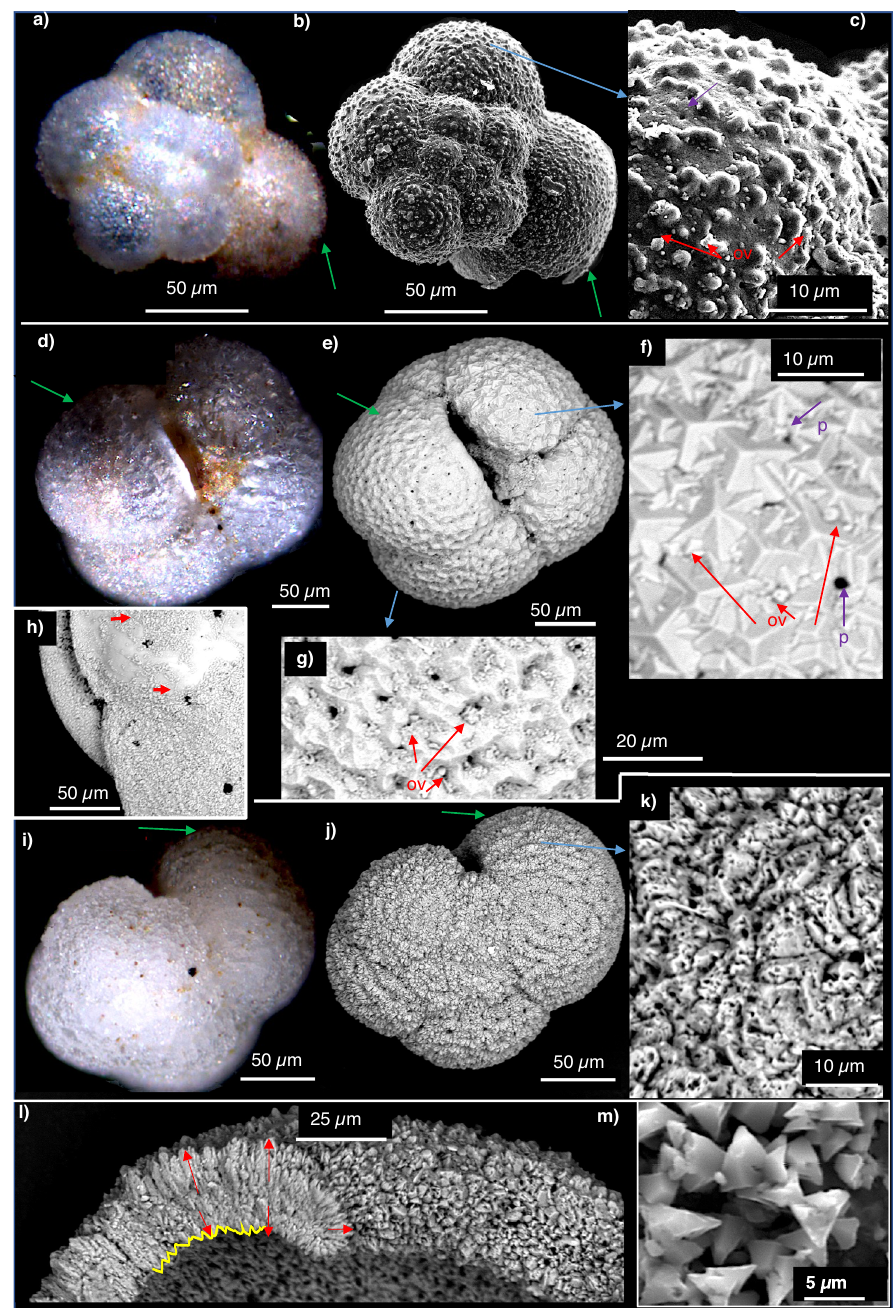
Fig. 2 Axio Zoom and SEM images of overgrowth. a – c Translucent N. pachyderma with primary shell and little overgrowth in the penultimate chamber and sediment-in fi lling in the last chamber. d – g Translucent N. pachyderma specimen with secondary calcite crust and minor ≤ 1 – 2- µ m-sized authigenic crystallites in depressions on the crystalline ( f ) and reticulate crust ( g ). The overgrowth often clogs the pores and contrasts with the smooth reticulate surface texture and the euhedral biologically precipitated crystals. h Cassidulina neoteretis (benthic foraminifera) patches of ≤ 1 – 2- µ m-sized authigenic crystallites on the otherwise smooth shell. i – k N. pachyderma encrusted by porous overgrowth. k At magni fi cations >4500 the porous structure of the overgrowth becomes apparent. l Cross-section through the last chamber of a different specimen shows tetrahedral overgrowth on the outer and inner shell wall (see the deviation from the usually smooth inner wall), but also authigenic calcite penetrating into the originally porous shell wall 99 . m Closed tetrahedral overgrowth. a , d , i stacked Axio Zoom, b - d , g – h , j – m SEM images. a – k , m PS413-3, l (PS2185-6). Core depth (cm) a – c 3.5, d – g 0.5, h 3.5, i – k 22.5, l , m 10.5. Arrows: green = last chamber, blue = penultimate chamber, red = authigenic crystals, purple = pore. Yellow line highlights the rough shell (Fig. 5b and Supplementary Table 5) reveal radiocarbon ages The ages of PI_2 and PI_3 specimens increase with core depth, (hereafter ages) comparable to those of PI_2 specimens. PI_1- hereby, PI_2 shells are invariably younger than PI_3 shells plateaus at 15.5 – 19.5 and 20.5 – 23.5 cm are attributed to down- (Fig. 5a, d). The age offset ranges from a few hundred to core displacement by bioturbation (for discussion see methods). thousands of years.